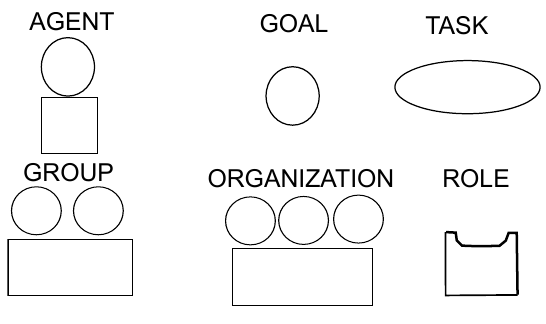
Figure 1. Meaning of some icons used in the system specification with